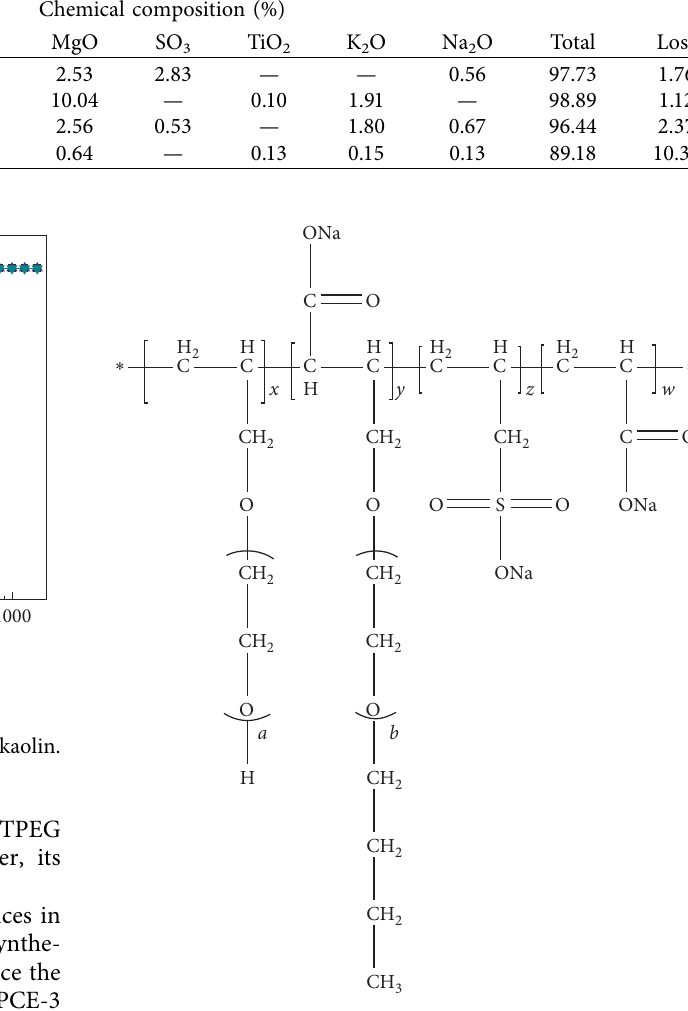
Figure 2: Structure of synthesized polycarboxylate.